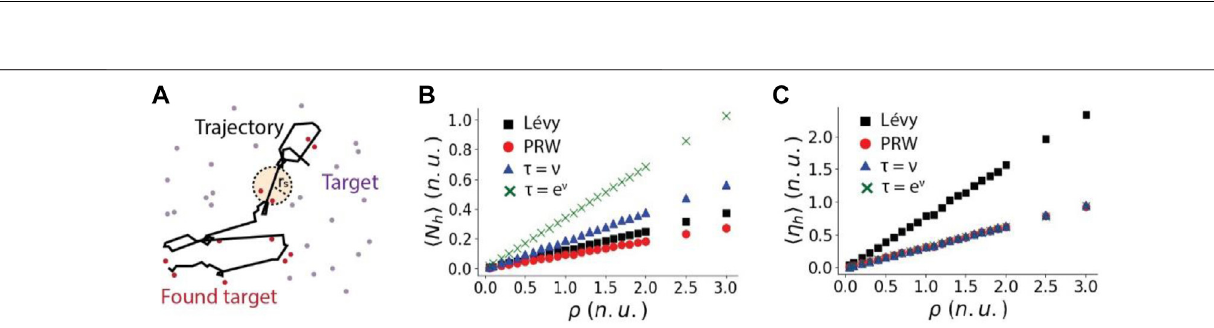
FIGURE 5 | The search ability 〈 N h 〉 and ef fi ciency 〈 η h 〉 of a particle in fl uenced by the moving strategies in the homogeneous environment. (A) , Schematic illustration of a particle searching for targets. When the distance between the target and the particle is less than r s (cid:2) 3in normalized units (n.u.), the target is assumed to be found by the particle. (B) , The number of targets found by the particle 〈 N h 〉 over the target density ρ in the homogeneous space. (C) , The search ef fi ciency 〈 η h 〉 over the target density ρ . The search ef fi ciencies of PRW, linear RWSP and nonlinear RWSP overlaps.